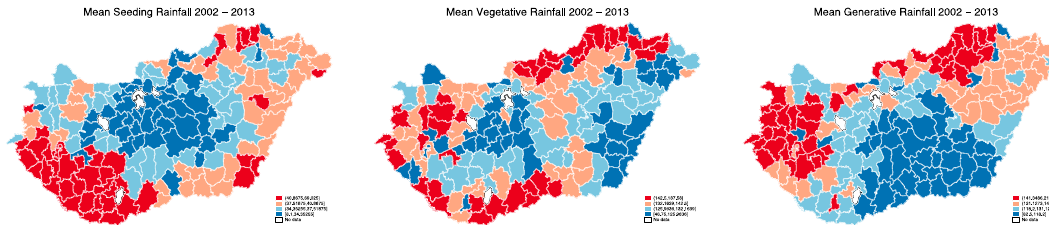
Figure 2. Mean seeding, vegetative and generative precipitation on a LAU1 level. Source: authors’ calculations based on EU Joint Research Center MARS-AGRI4CAST [22].